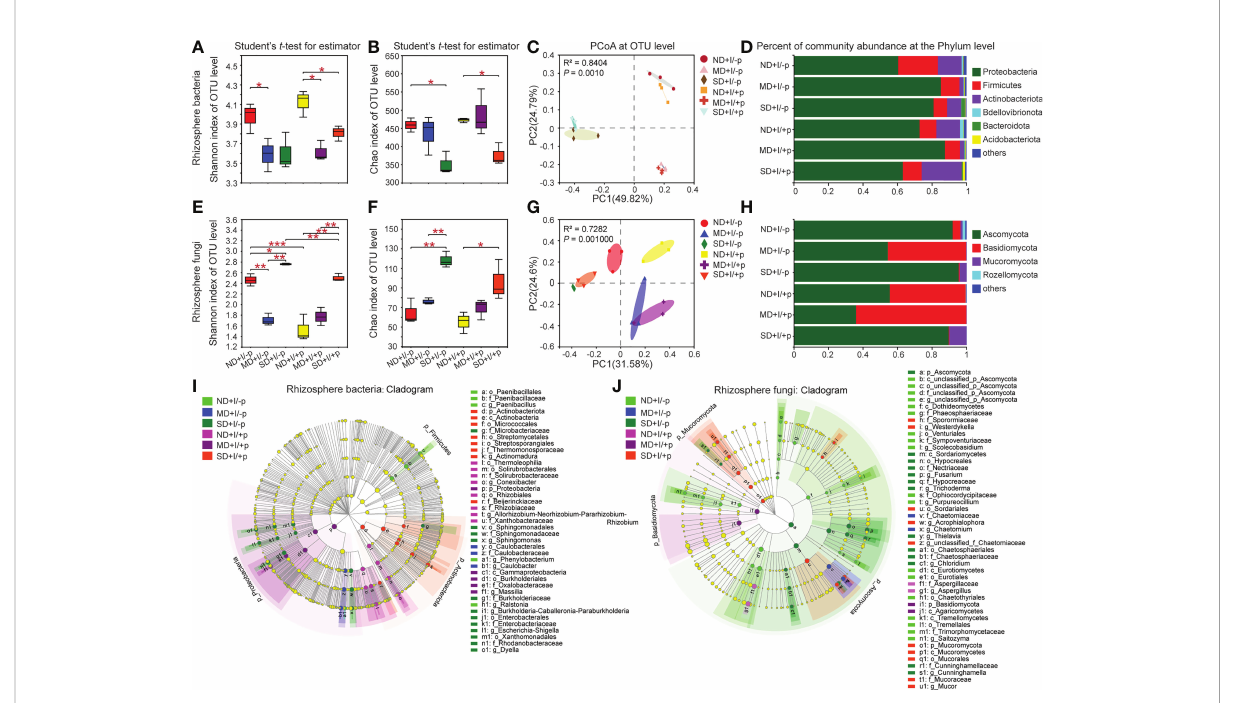
FIGURE 3 Diversity and community structure of rhizosphere bacteria and fungi of A. lancea . Shannon index (A, E) shows a diversity, Chao1 index (B, F) shows richness, both at the OTU level. C and G: PCoA of rhizosphere bacteria (C) and Fungi (G) in A. lancea based on Bray-Curtis matrix at the OTU level (n = 3). D and H: Bar chart of rhizosphere bacteria (D) and fungi (H) in A. lancea rhizosphere at phylum level. (I, J) Cladogram showing the phylogenetic distribution of the bacterial ( I , LDA score = 4) and fungal ( J , LDA score = 2) lineages associated with the bottled soil and rhizosphere soil of A. lancea . Circles indicate phylogenetic level from phylum to genus. The diameter of each circle is proportional to the abundance of the group. Asterisks represent signi fi cant difference by Student ’ s t-test: * P < 0.05; ** P < 0.01; *** P < 0.001; ND, no drought stress, 0% PEG6000; MD, mild drought stress, 10% PEG6000; SD, severe drought stress, 25% PEG6000; +I, with Geo-authentic soil microbe inoculation; +p, with A. lancea